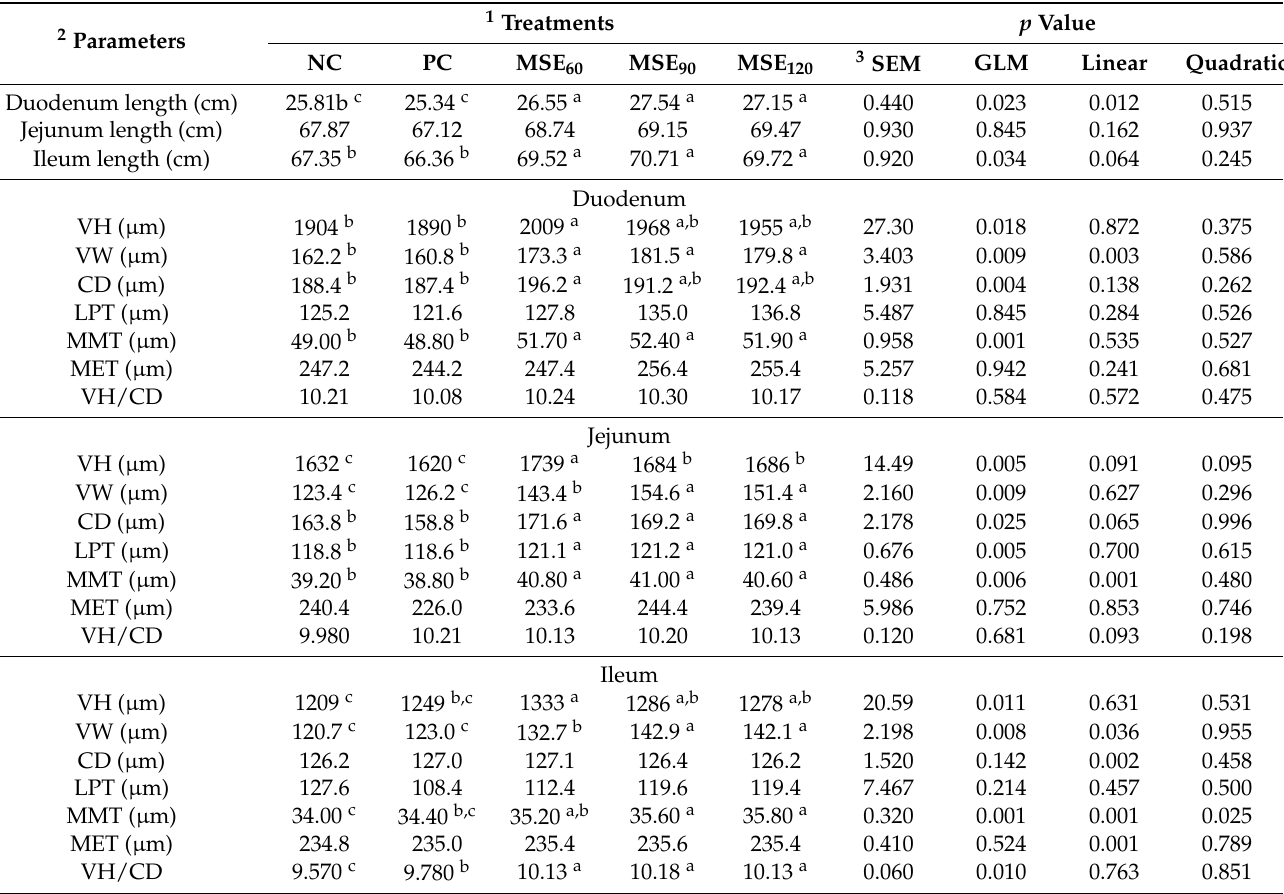
Table 2. Intestinal morphometric parameters of six-week-old broiler chickens ( n = 125) orally admin- istered with varying levels of moringa seed extract (MSE) in drinking